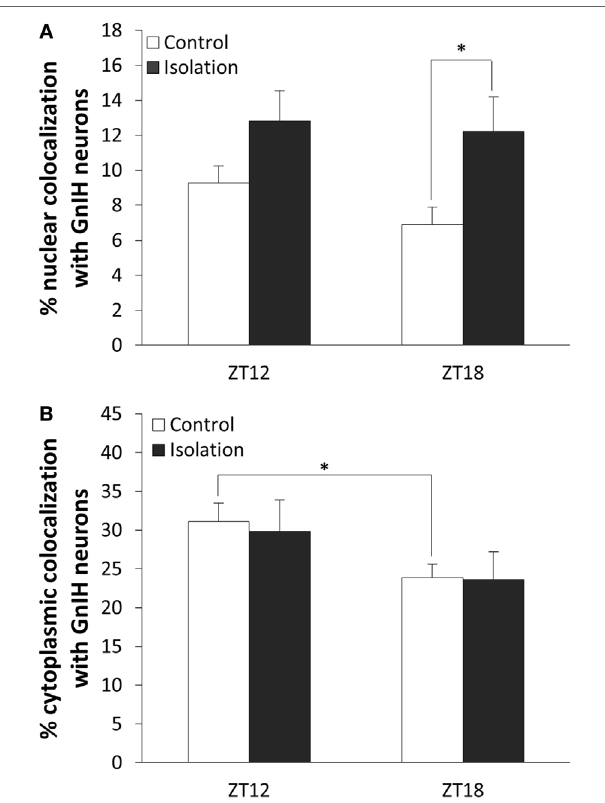
FigUre 5 | The effect of postweaning social isolation on β -catenin colocalization with gonadotropin-inhibitory hormone (GnIH) neurons in the dorsomedial hypothalamus region. (a) Comparison of β -catenin nuclear colocalization within GnIH neurons of the control and isolated rats at ZT12 and ZT18 (control: n = 6 and isolation: n = 6 for ZT12 and control: n = 9 and isolation: n = 9 for ZT18). (B) Comparison of β -catenin cytoplasmic colocalization in GnIH neurons of control and isolated rats in ZT12 and ZT18 (control: n = 6 and isolation: n = 6 for ZT12 and control: n = 9 and isolation: n = 9 for ZT18). Data are presented as means ± SEM for each set. Significance was set at p <